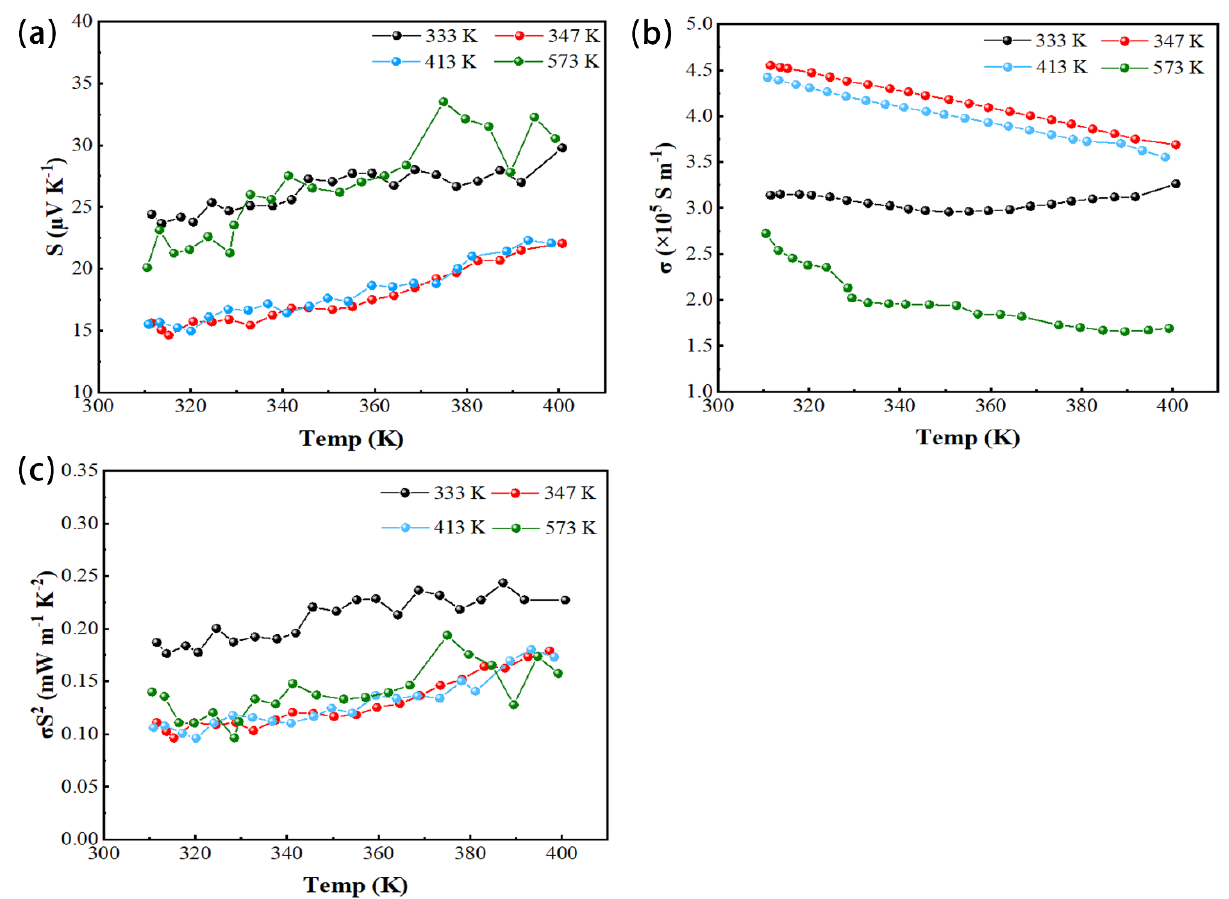
Figure 5. Thermoelectric properties of Cu 2 Se film on glass substrate prepared at various temperatures. ( a ) Seebeck coefficient S , ( b ) electrical conductivity σ , and ( c ) power factor ( PF ) σ S 2 of the film measured in the helium atmosphere.